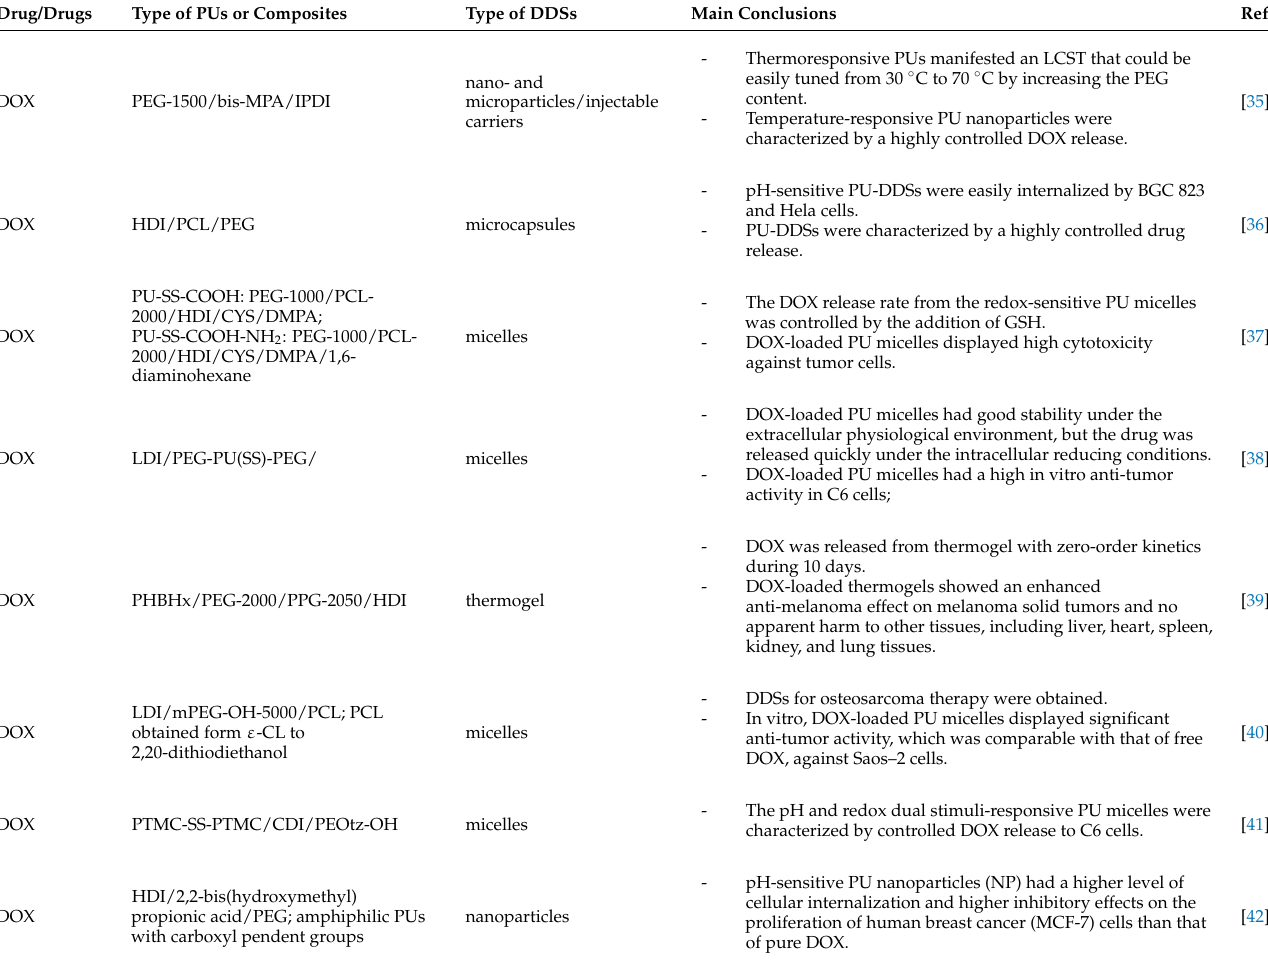
Figure 5. Types of polyurethane drug delivery systems for anti-cancer drugs. Table 1. Polyurethane drug delivery